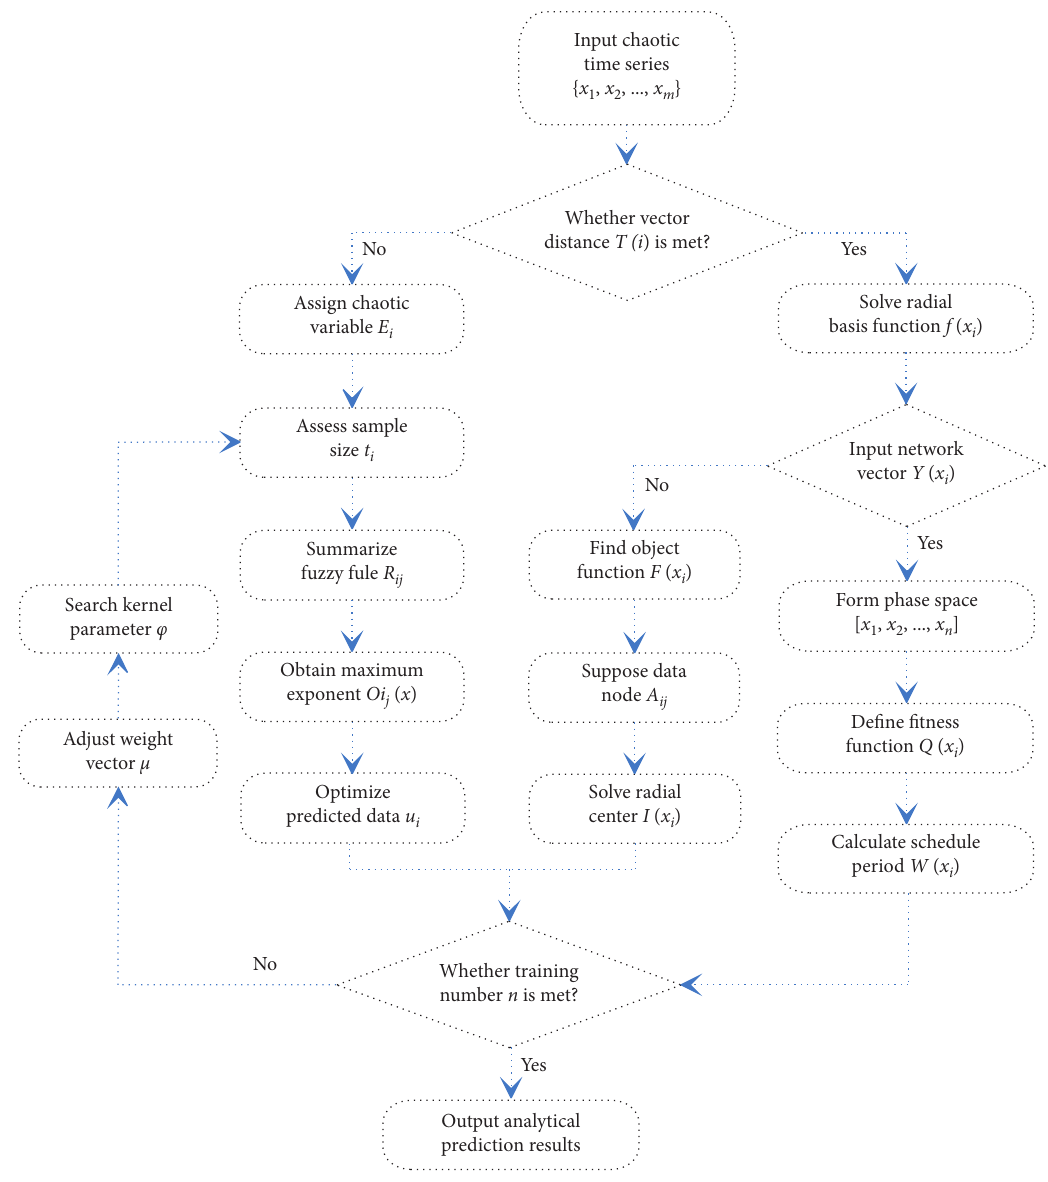
Figure 2: Analytical flowchart of economic chaotic time series prediction based on chaotic genetics combined with fuzzy decision